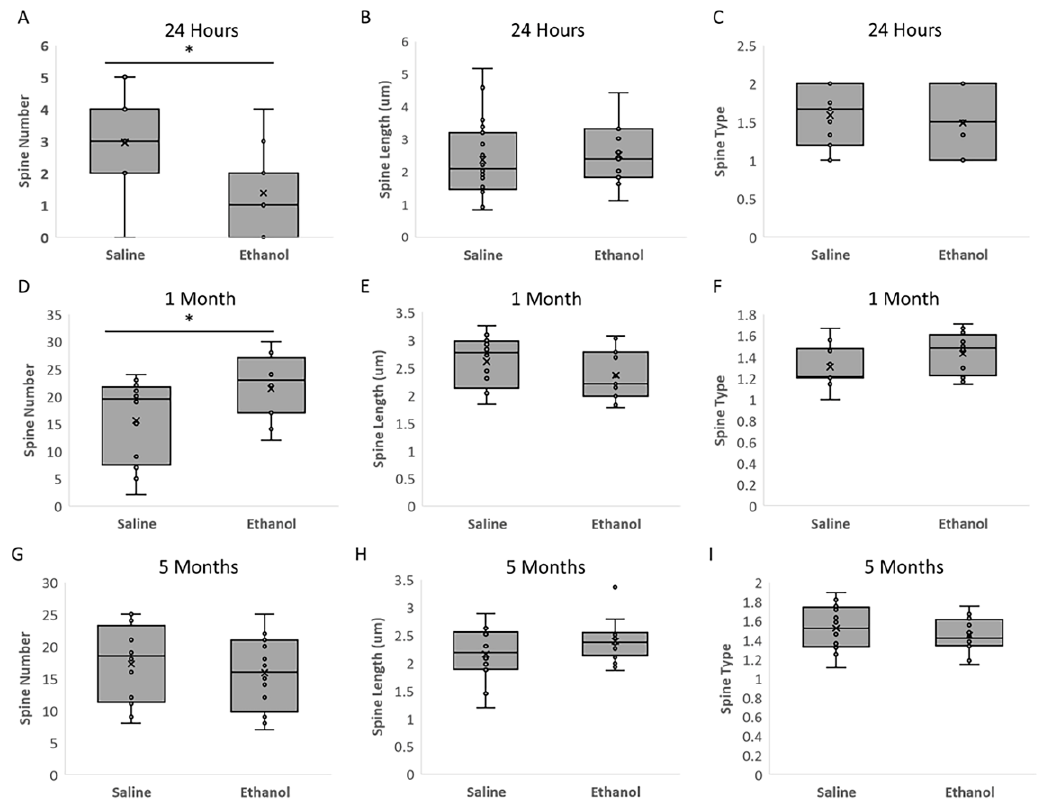
Figure 3. Acute high-dose ethanol administration during synaptogenesis significantly affects dendritic spine number. ( A – C ). Twenty-four hours post-ethanol administration: ( A ). number of dendritic spines was significantly decreased in etha- nol-treated animals 24 h after exposure ( p = 0.002), but there was not sufficient statistical power to determine if there was an effect on spine length ( B ); Power: 0.744) or spine type ( C ); power: 0.7003). ( D – F ). One-month post-ethanol administra- tion: ( D ). number of dendritic spines was significantly increased in ethanol-treated animals 1 month after exposure ( p = 0.030), but there was no significant effect of treatment on spine length ( E ); p = 0.944). There was not sufficient statistical power to determine if there was an effect on spine type ( F ); Power: 0.4577). ( G – I ). Five months post-ethanol administration: No significant differences were detected between ethanol and saline groups 5 months after treatment for spine number ( G ), spine length ( H ), or spine type ( I ), but there was insufficient statistical power to determine the impact of ethanol treatment (power: 0.4496, 0.4577, and 0.5183, respectively). For spine analysis, 3–5 animals were used in each treatment group ( n = 5 saline and 4 ethanol at 24 h; n = 3 saline and n = 3 ethanol at 1 month; n = 3 saline and n = 4 ethanol at 5 months). *: significant at p <